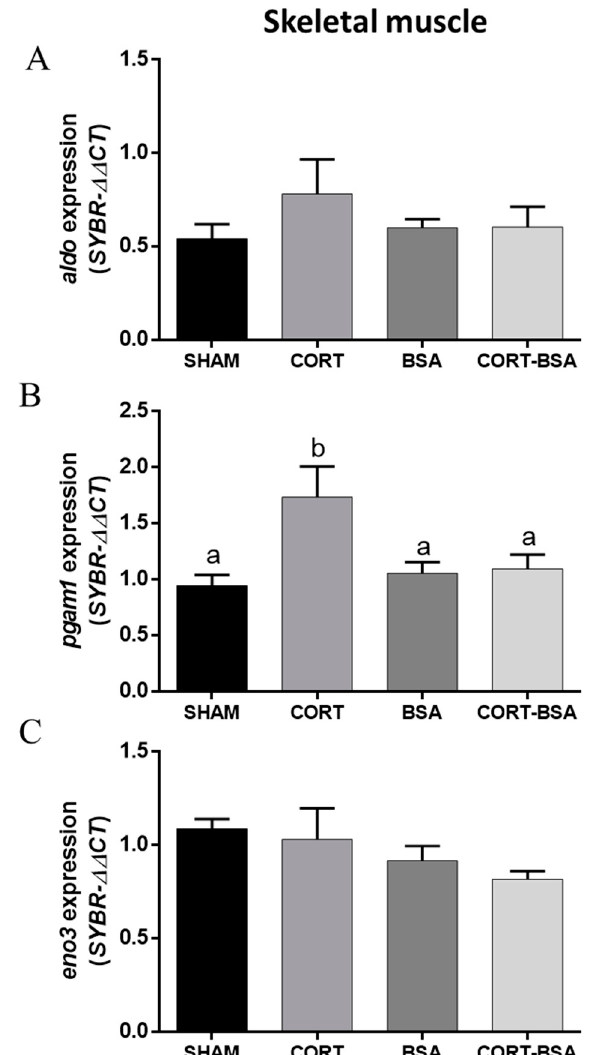
Figure 5. Glucose-metabolism related genes expression in skeletal muscle. Expression of glycolysis- related genes aldo ( A ), pgam1 ( B ), eno3 ( C ) were evaluated in vehicle (sham-control), cortisol, BSA and cortisol-BSA administered fish at 72 h post-treatment. Results are expressed as mean ± SEM ( n = 8). Different letters indicate significant differences between groups ( p value < 0.05). All data were analyzed using one-way ANOVA and Tukey’s HSD as a post-hoc test.